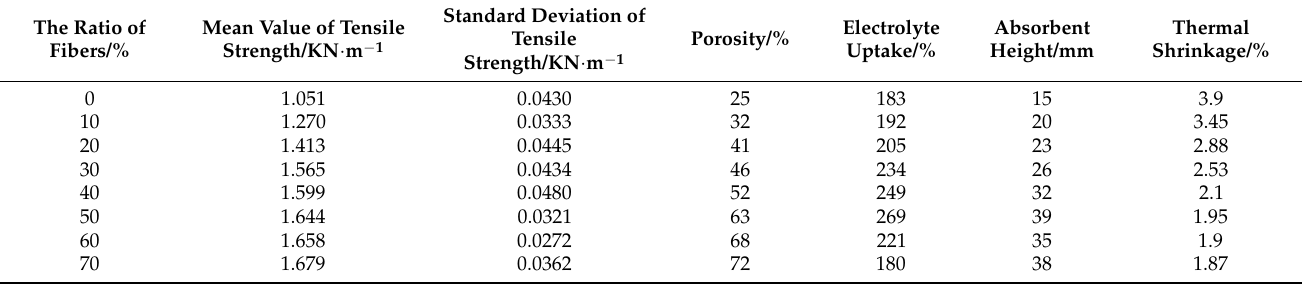
Figure 2. The effect of fibers’ ratio for tensile strength. Table 1. Physical properties of composite membranes with different fiber ratios.